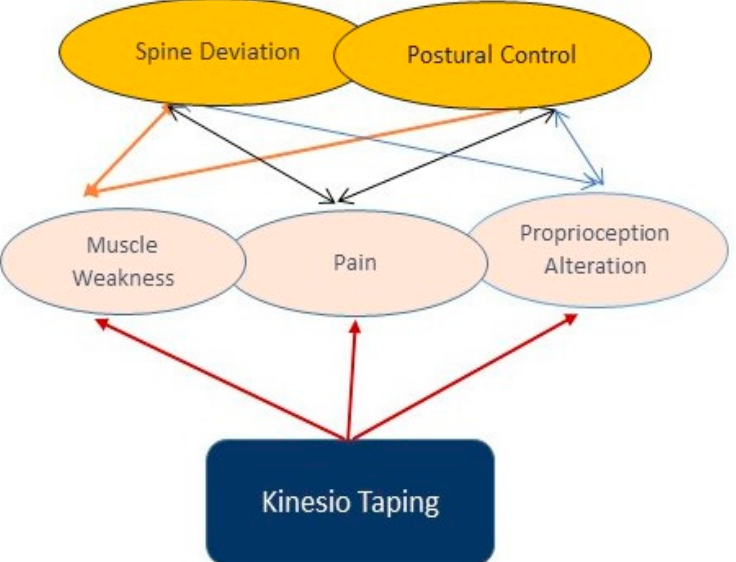
Figure 2. Schematic graph illustrating the indirect influence of Kinesio Taping (KT) on spine disorders and postural control [4,8,27,29–31].